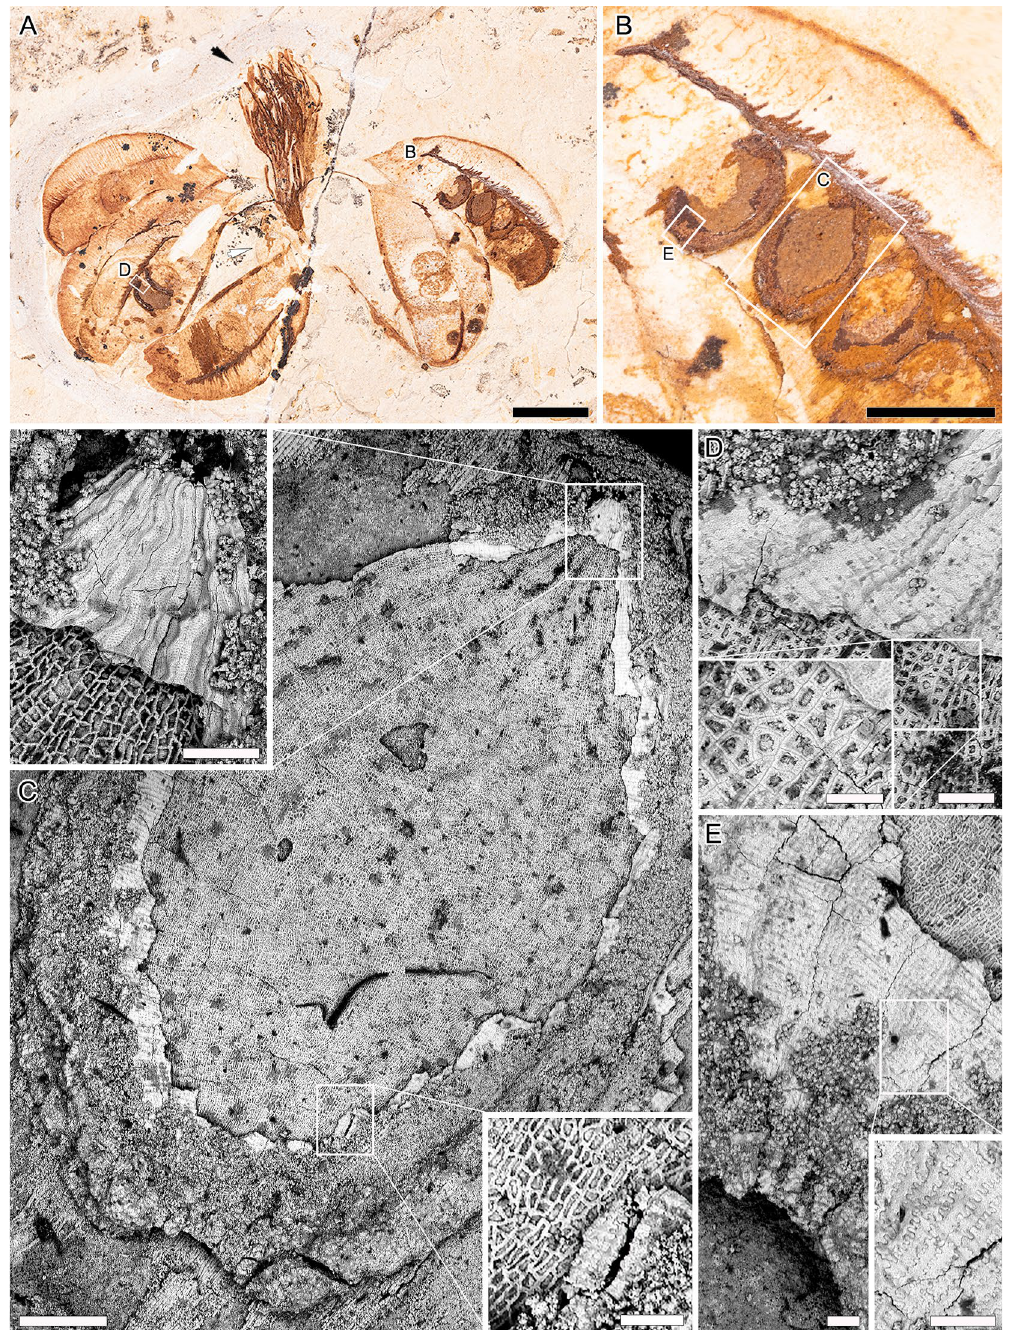
Figure 3. Santaniella lobata gen. nov. et sp. nov. ( A – E ) paratype (MB. Pb. 1997/1562); ( A ) fruit with one outer (white arrow) and several inner (black arrow) erect and laciniate persistent perianth-like organs surrounding the stalks of 6 stipitate, reflexed and pendulous follicles; ( B ) close-up of 3(-4) permineralized seeds; ( C – E ) SEM images of seeds; ( C ) whole seed with inserts showing higher magnification of the outer and inner layers of seed coat in the micropylar and chalazal region. Note the jigsaw puzzle-shaped surface cells in chalazal region; ( D ) close-up of the micropylar region with spiral structures inside the cells of the innermost layer of the seed coat; (E) close-up of the chalazal region with jigsaw puzzle outer layer of the seedcoat. Scale bars: ( A , B ) = 1 cm; ( C ) = 500 μm, ( C ) close-ups = 100 μm; ( D ) = 100 μm, ( D ) close-up = 50 μm; ( E ) and ( E ) close-up = 100